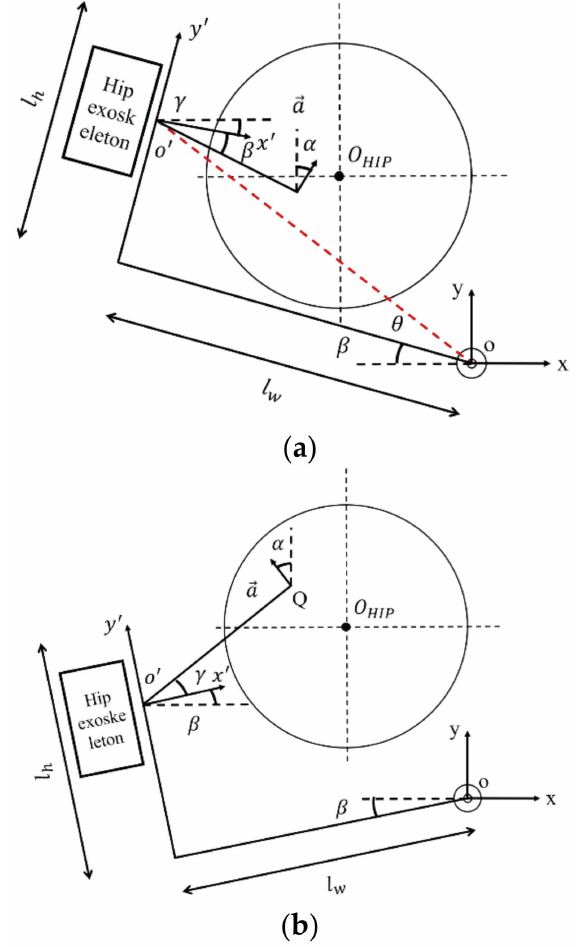
Figure 6. Geometric model of internal/external rotation of hip joint: ( a ) Interior rotation plane diagram of lumbar exoskeleton structure, ( b ) Interior rotation plane diagram of lumbar exoskeleton structure. In Figure 6, l w represents the total length of the posterior lumbar connection, l h repre- sents the length of the hip joint connection frame, and the angle θ satisfies θ = arctan l h / l w . The point of projection of the hip exoskeleton in the axis of internal/external rotation is Q. In the O-xy coordinate system, the ideal position O HIP is at coordinates ( x 0 , y 0 ) in the O-xy coordinate system, and the point Q is at coordinates ( x Q , y Q ). The angular relationship in the diagram satisfies α = β + γ , and the forward direction vector of the human lower-limb thigh is a . When the hip exoskeleton rotates with the waist rotation axis as the center in internal/external rotation movements, the exoskeleton size is constant, and the